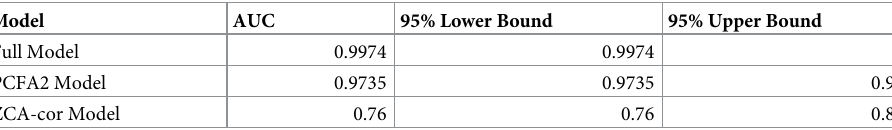
Table 4. Area under the curve per model with their 95% confidence